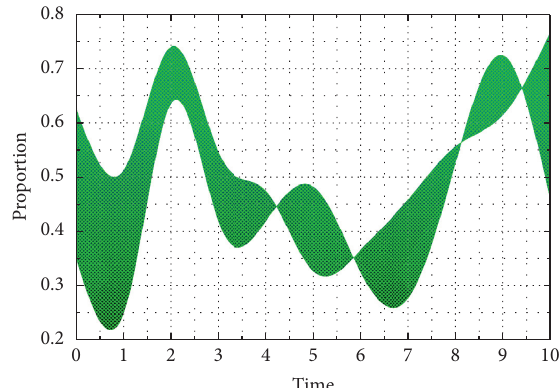
Figure 5: Dynamic evolution of state I